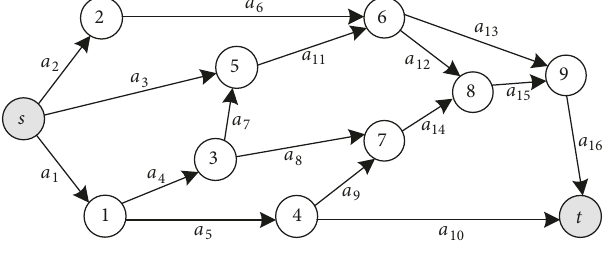
Figure 5: A power transmission